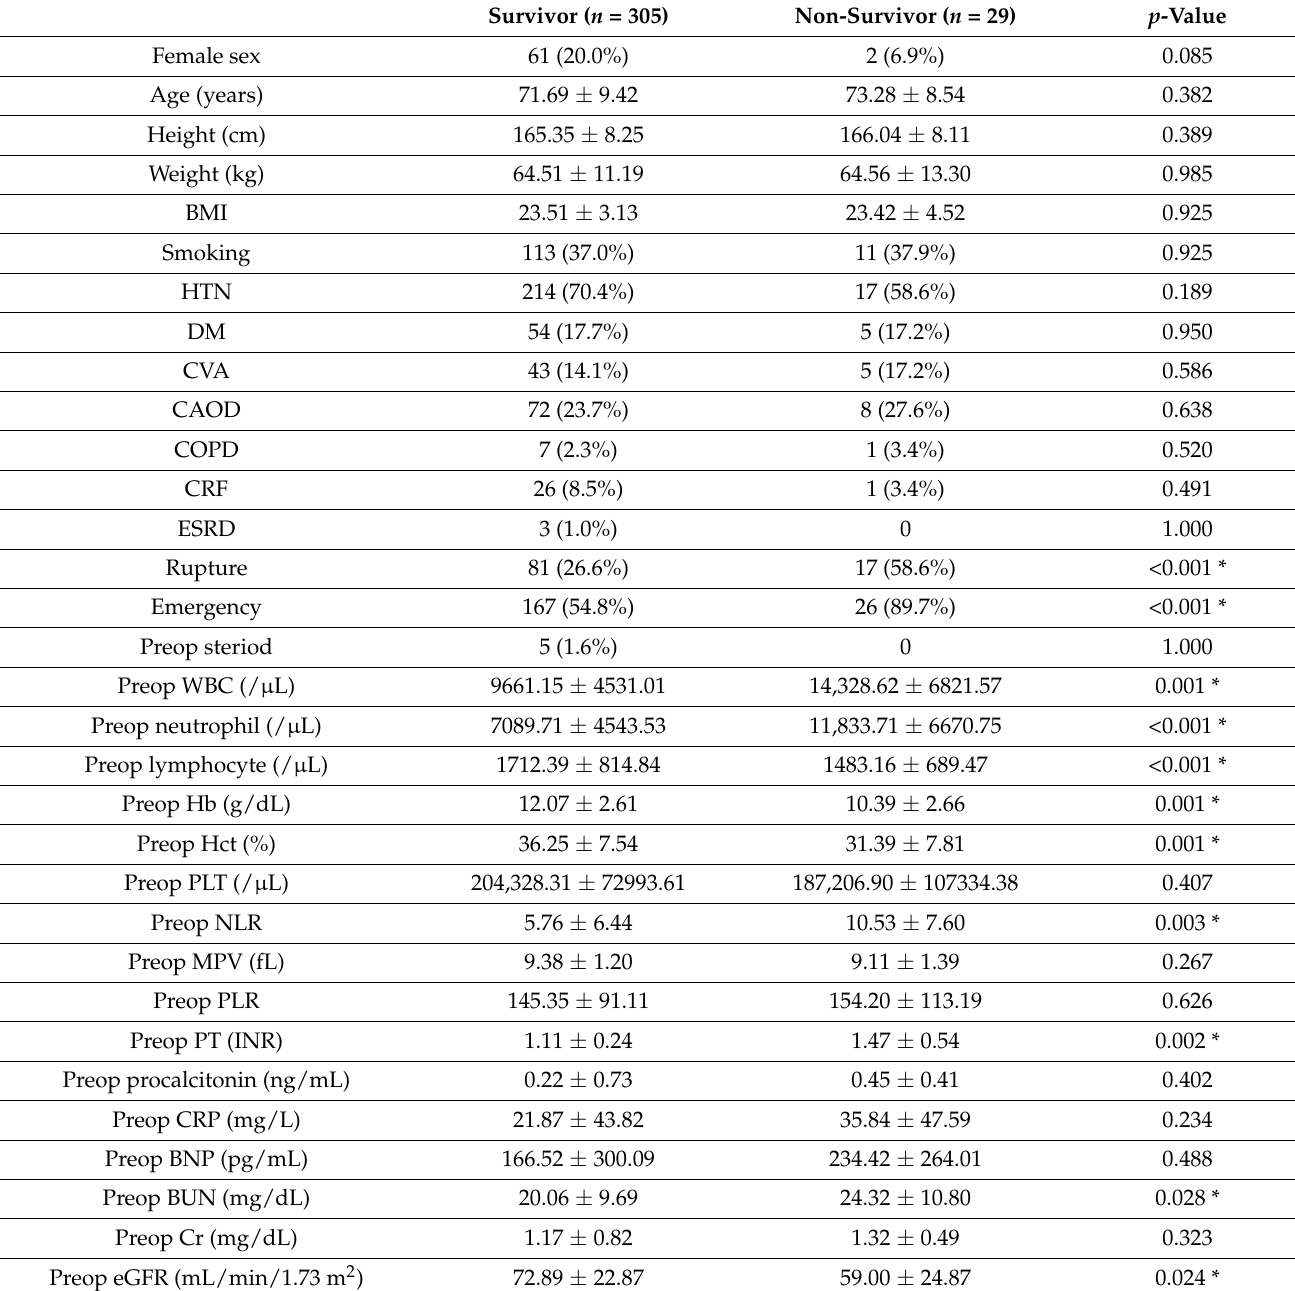
Table 1. Baseline characteristics and laboratory data, stratified according to 1-year